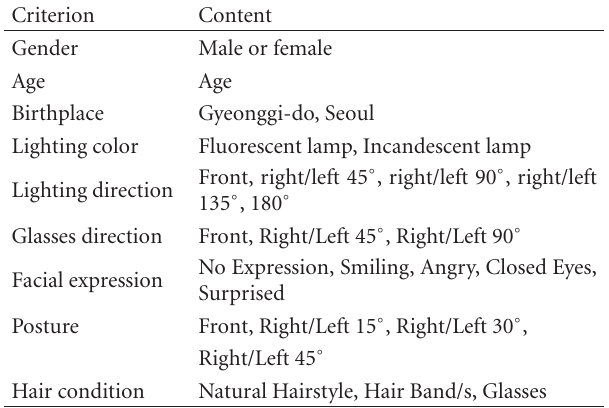
Table 2: Classification of the KISA’s